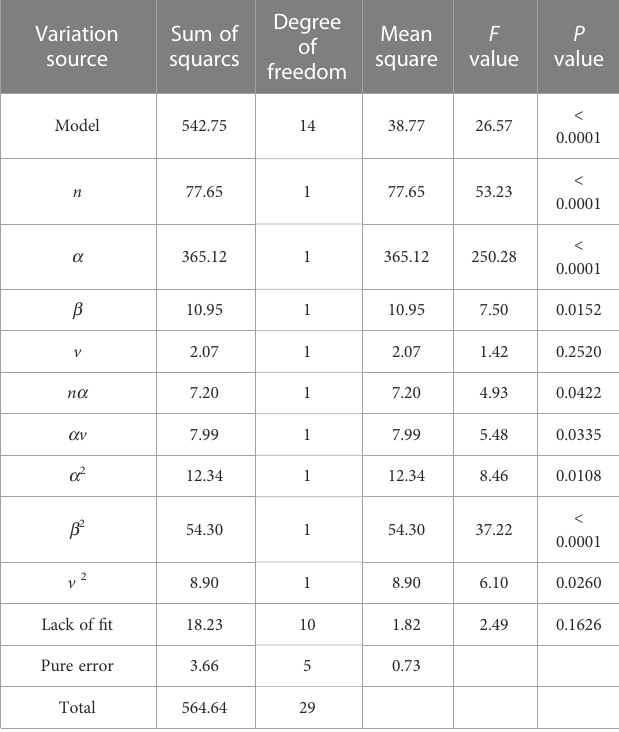
Variation source